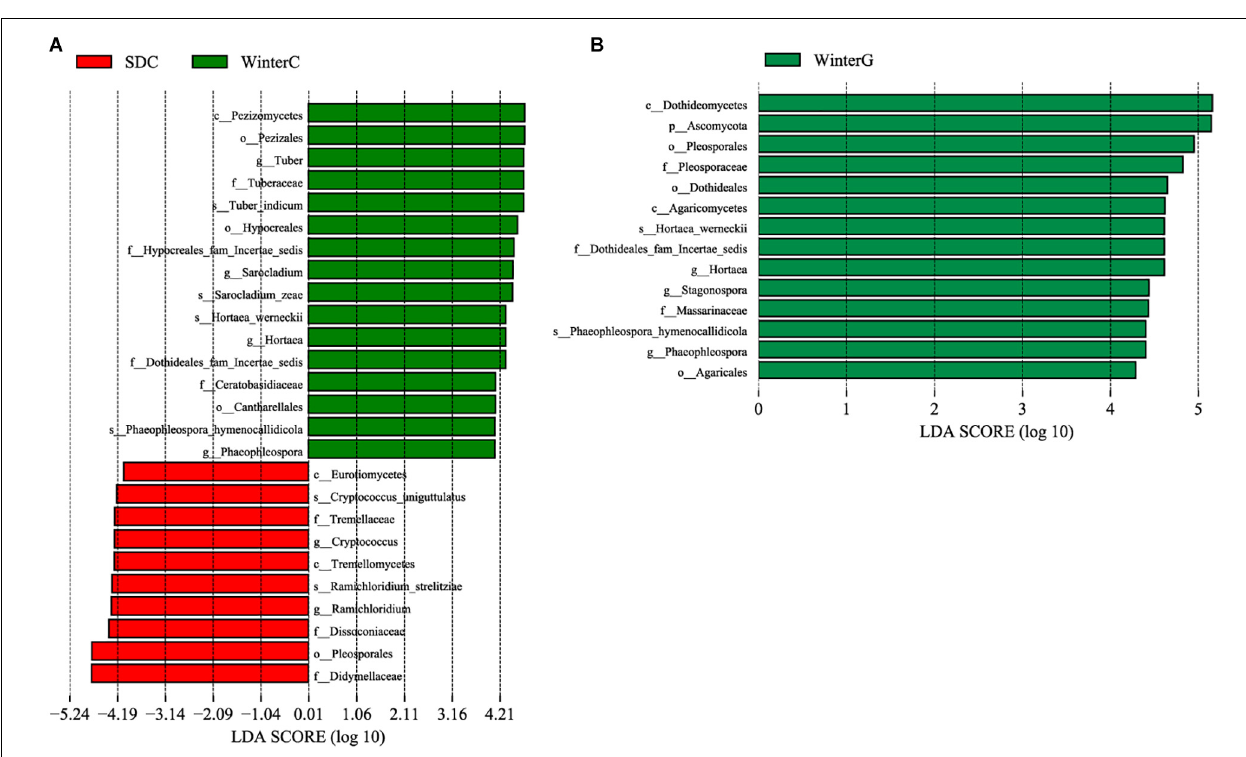
FIGURE 5 | Differences among summer and winter groups were determined by LEfSe. The highlighted taxa were significantly enriched in the group that corresponds to each color. LDA scores can be interpreted as the degree of difference in relative abundance. (A) Comparison between summer and winter intestinal samples; (B) comparison between summer and winter hepatopancreas samples. p_, phylum, c_class, o_order, f_, family, g_, genus and s_, species; WinterC, winter intestinal group; WinterG, winter